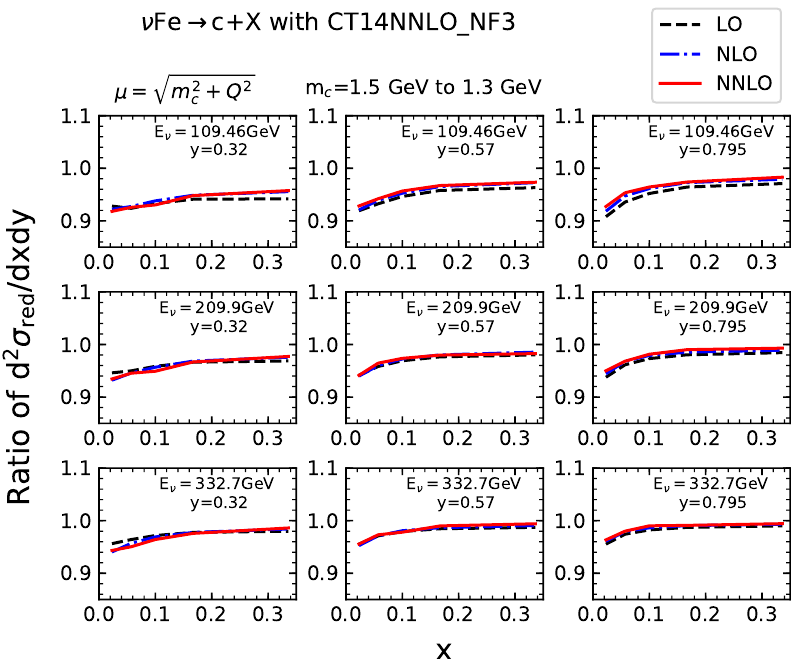
Figure 6 . Dependence of a double di(cid:11)erential reduced cross section in Bjorken x and inelasticity y on the charm quark mass, shown in ratios of predictions with m c = 1 : 5 GeV to 1.3 GeV, for charm quark production from neutrino scattering on iron